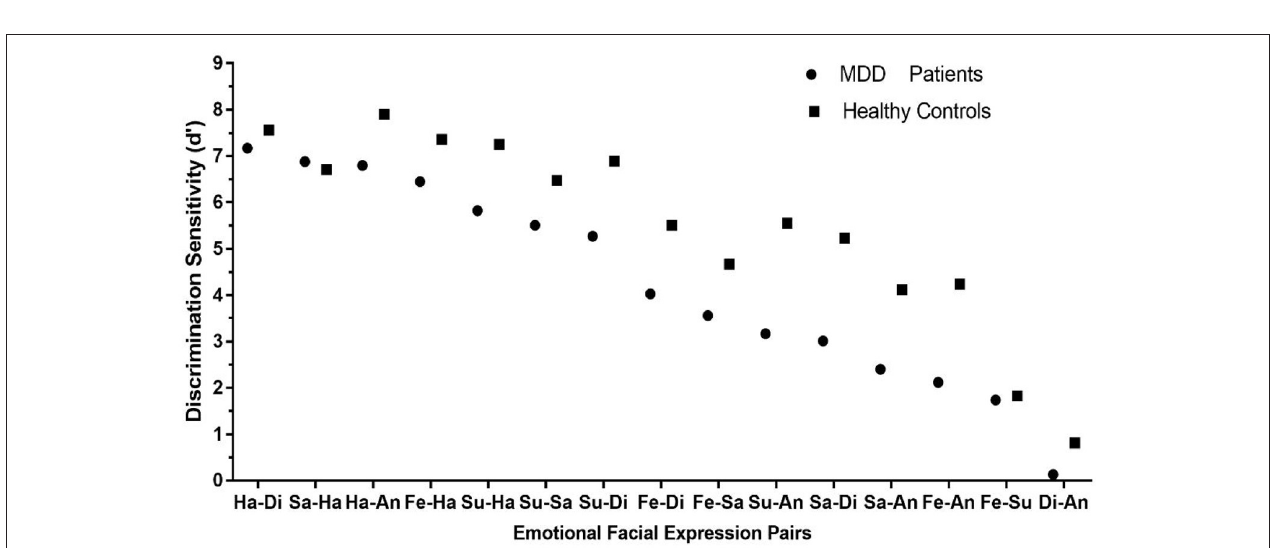
FIGURE 5 | The scatter diagram of discrimination sensitivities (d ′ ) in patients with MDD and healthy